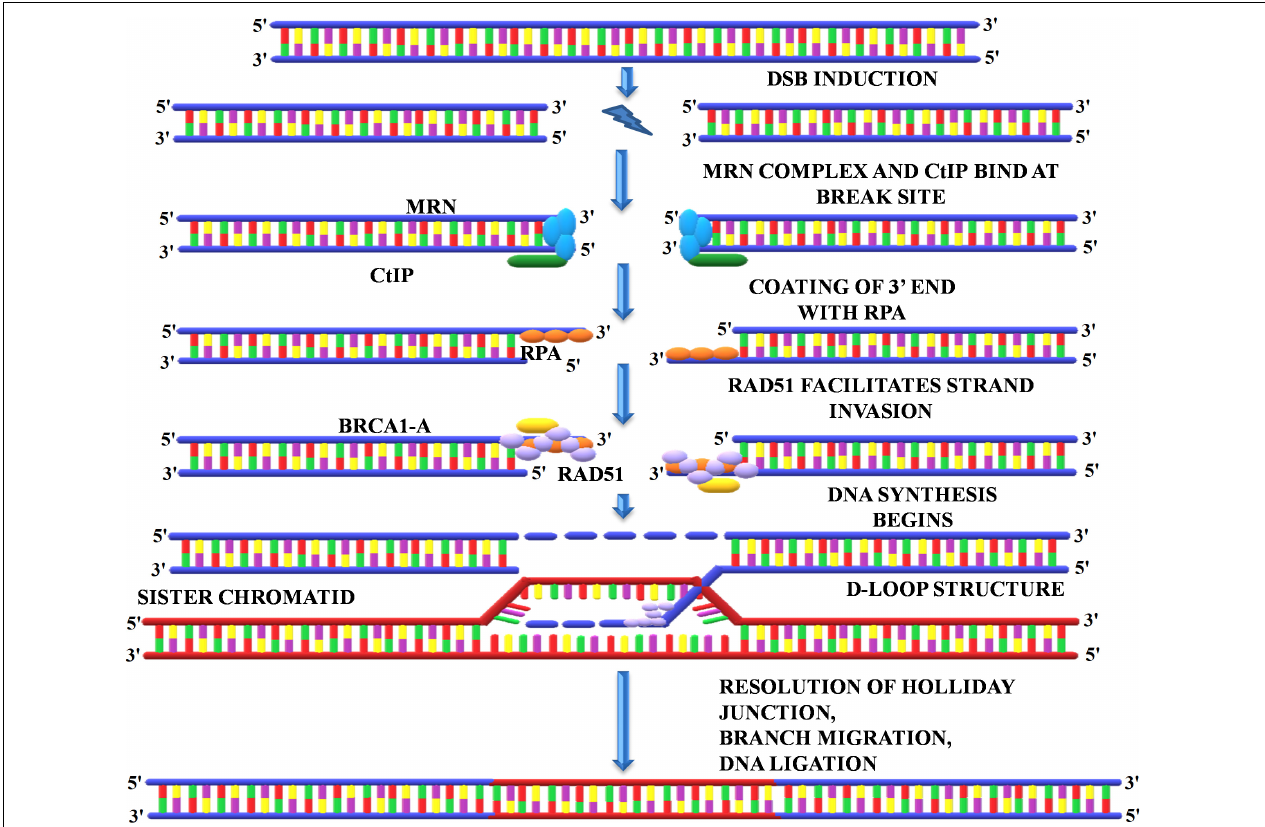
FIGURE 8 | Homologous recombination repair. The HRR initiates with the recruitment of MRN, and CtIP complex at the repair site activates the kinases such as ATM and ATR. The MRN complex degrades the 3’ end followed by coating with replication protein A and binding of BRCA1/2, which subsequently recruits RAD51 and initiates DNA synthesis. RAD51 displaces the bound RPA and facilitates strand invasion into the homologous template that generates the D-Loop and Holliday junction, which are eventually resolved by resolvase. MRN, Mre11-Rad50-Nbs1; CtIP, carboxy-terminal interacting protein; ATM, ataxia telangiectasia mutated; ATR, ataxia telangiectasia mutated and Rad3 related; BRCA1/2, breast cancer1/2; RAD51, radiation sensitive